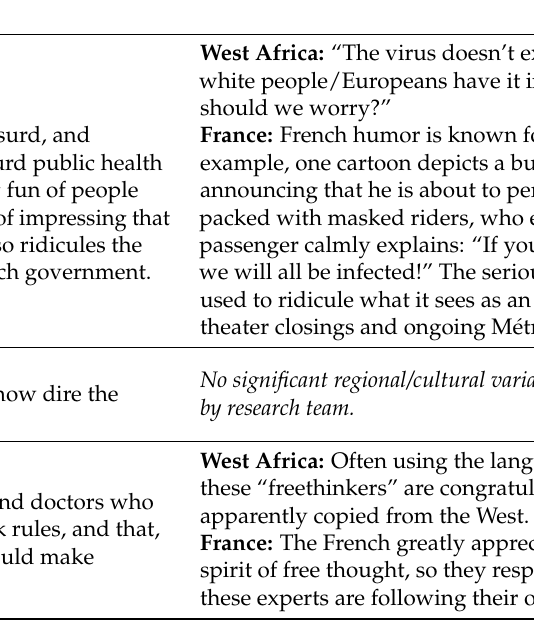
Table 2. Rhetorical Strategies (in English and